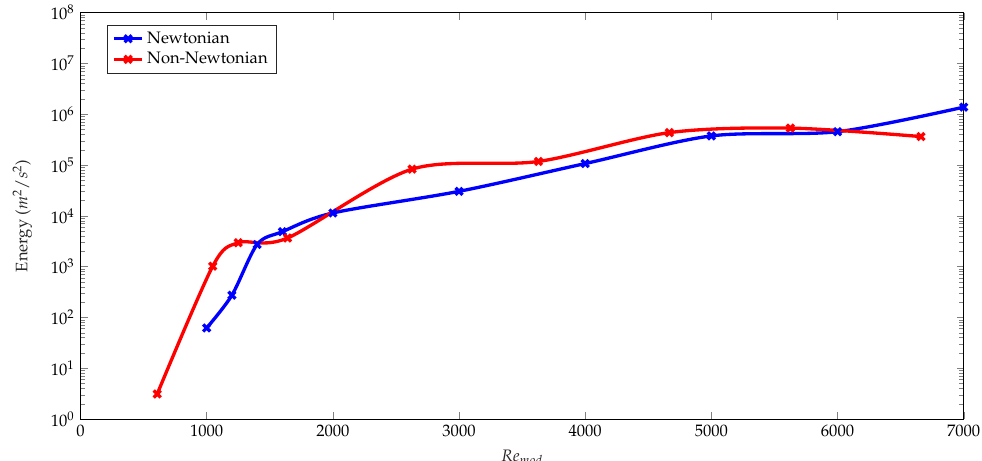
Figure 19. Turbulence intensity of Newtonian and shear-thinning blood rheology plotted against modified Reynolds number Re mod .